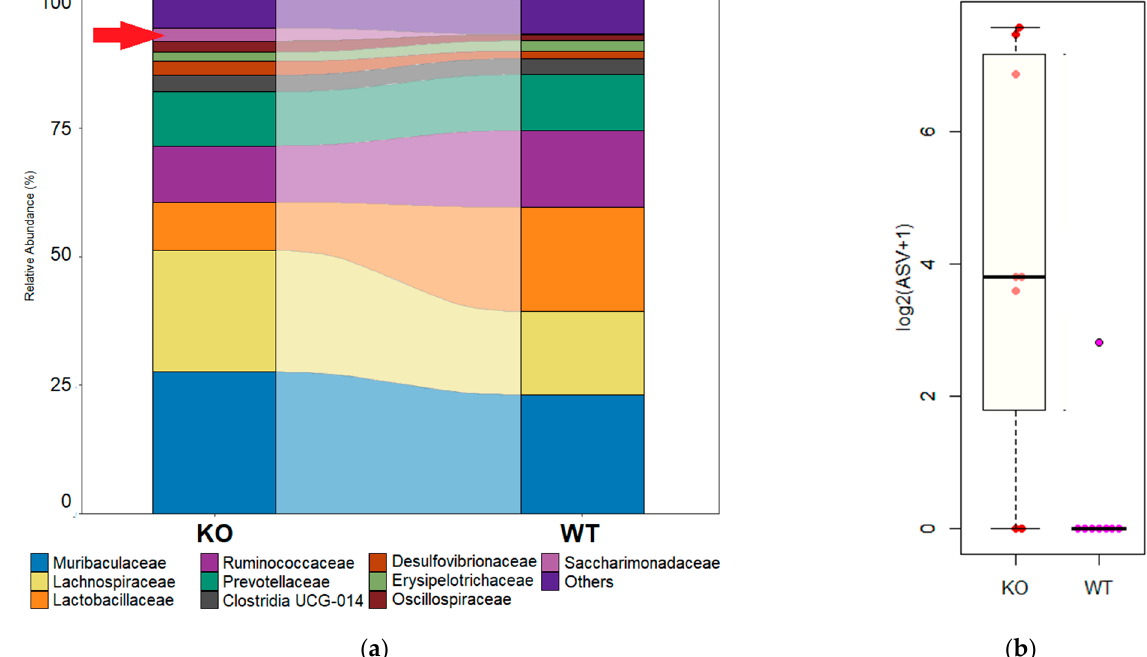
Figure 4. Microbiome analysis revealed higher Saccharimonadaceae prevalence in the fecal microbiota of TAAR9-KO compared with wild-type littermates. ( a ) The averaged relative abundance at the family level in TAAR9-KO and wild-type rats (top 10 most abundant families are represented); ( b ) the abundance of Saccharimonadaceae in fecal microbiome in TAAR9-KO and wild-type rats. Asv—Amplicon Sequence Variant; KO—TAAR9-KO Group; Wt—Wild-Type Control